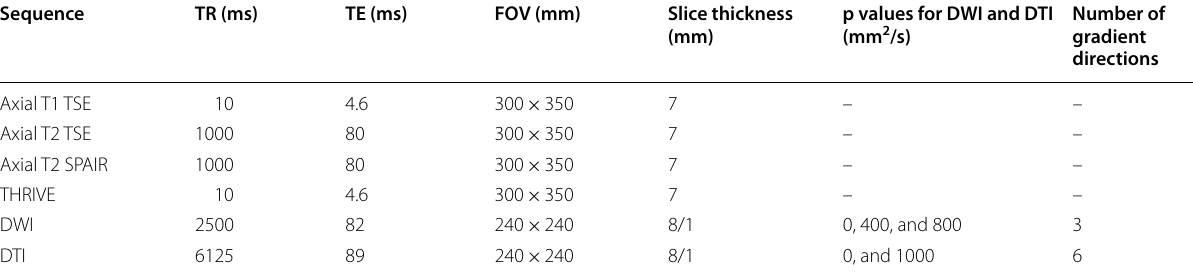
p values for DWI and DTI (mm) (mm 2 /s)